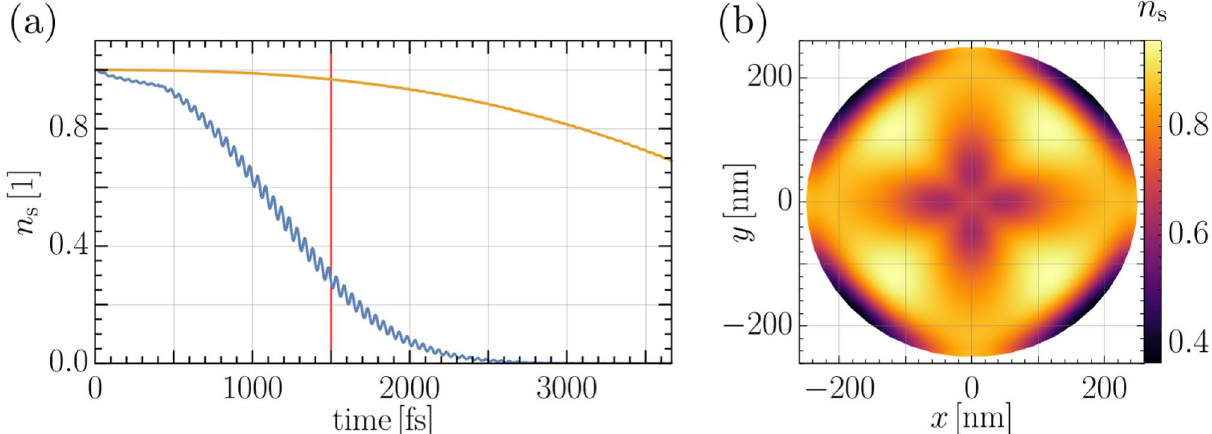
Figure 2. ( a ) The minimum (blue curve) and maximum value (orange curve) of the local density of Cooper pairs n s under the influence of the vector potential. ( b ) Snapshot of n s at z red line.